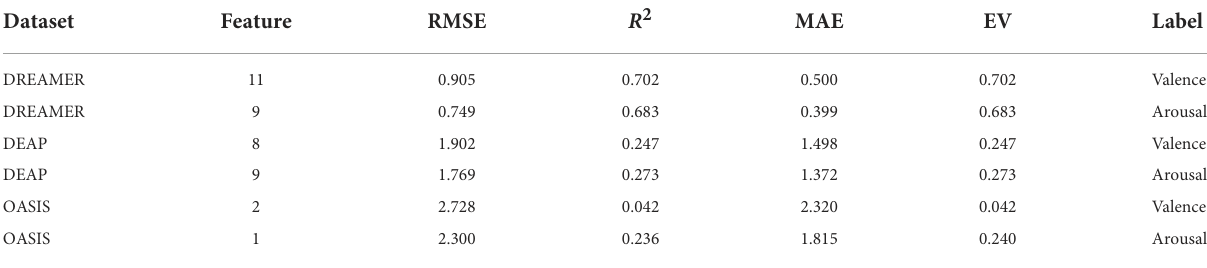
TABLE 4 Regression evaluation metrics values for valence and arousal labels on the test set (20%) of DEAP, DREAMER, and OASIS datasets for the optimum set of features. Dataset